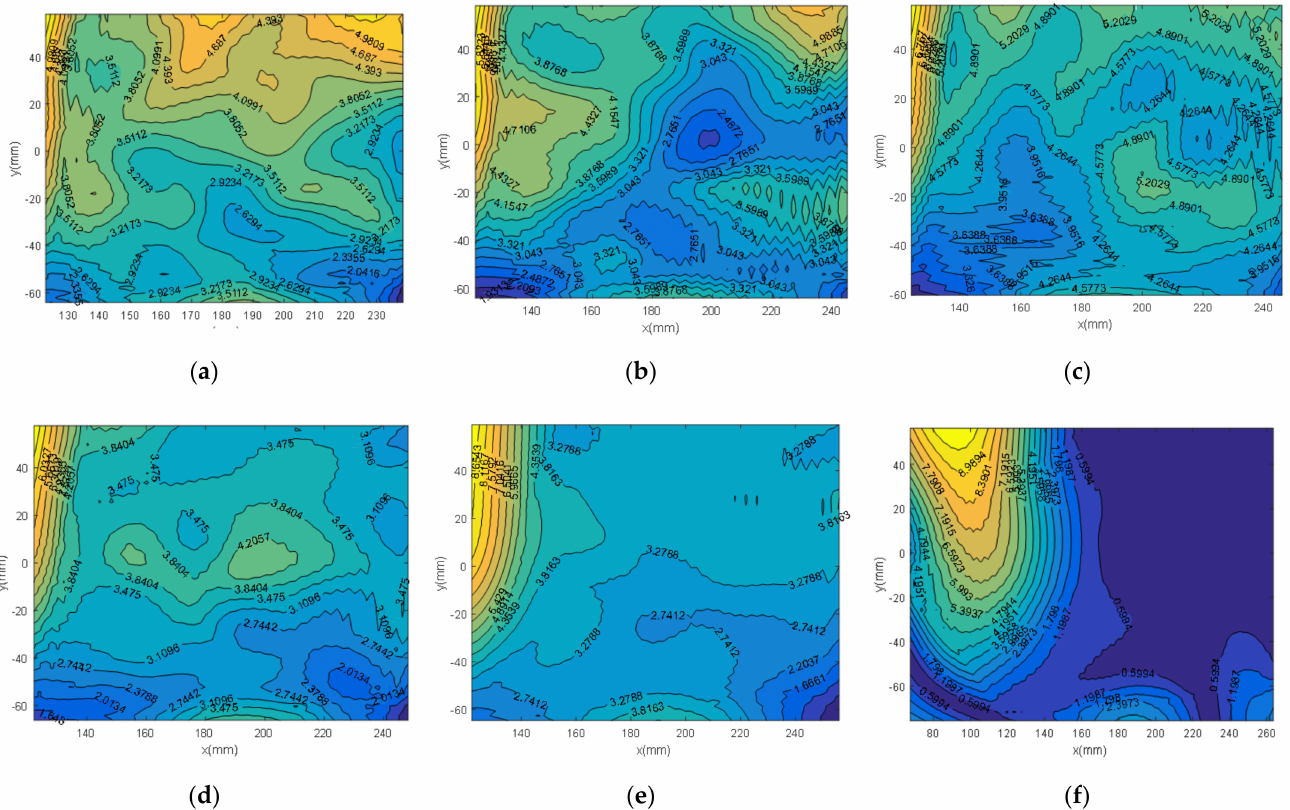
Figure 13. Absolute error distribution between reconstructed WAI and the ground truth for the different θ sun using Alterman’s method. ( a ) Absolute error distribution when θ sun = 0 ◦ ; ( b ) absolute error distribution when θ sun = 15 ◦ ; ( c ) absolute error distribution when θ sun = 30 ◦ ; ( d ) absolute error distribution when θ sun = 45 ◦ ; ( e ) absolute error distribution when θ sun = 60 ◦ ; ( f ) absolute error distribution when θ sun = 75 ◦